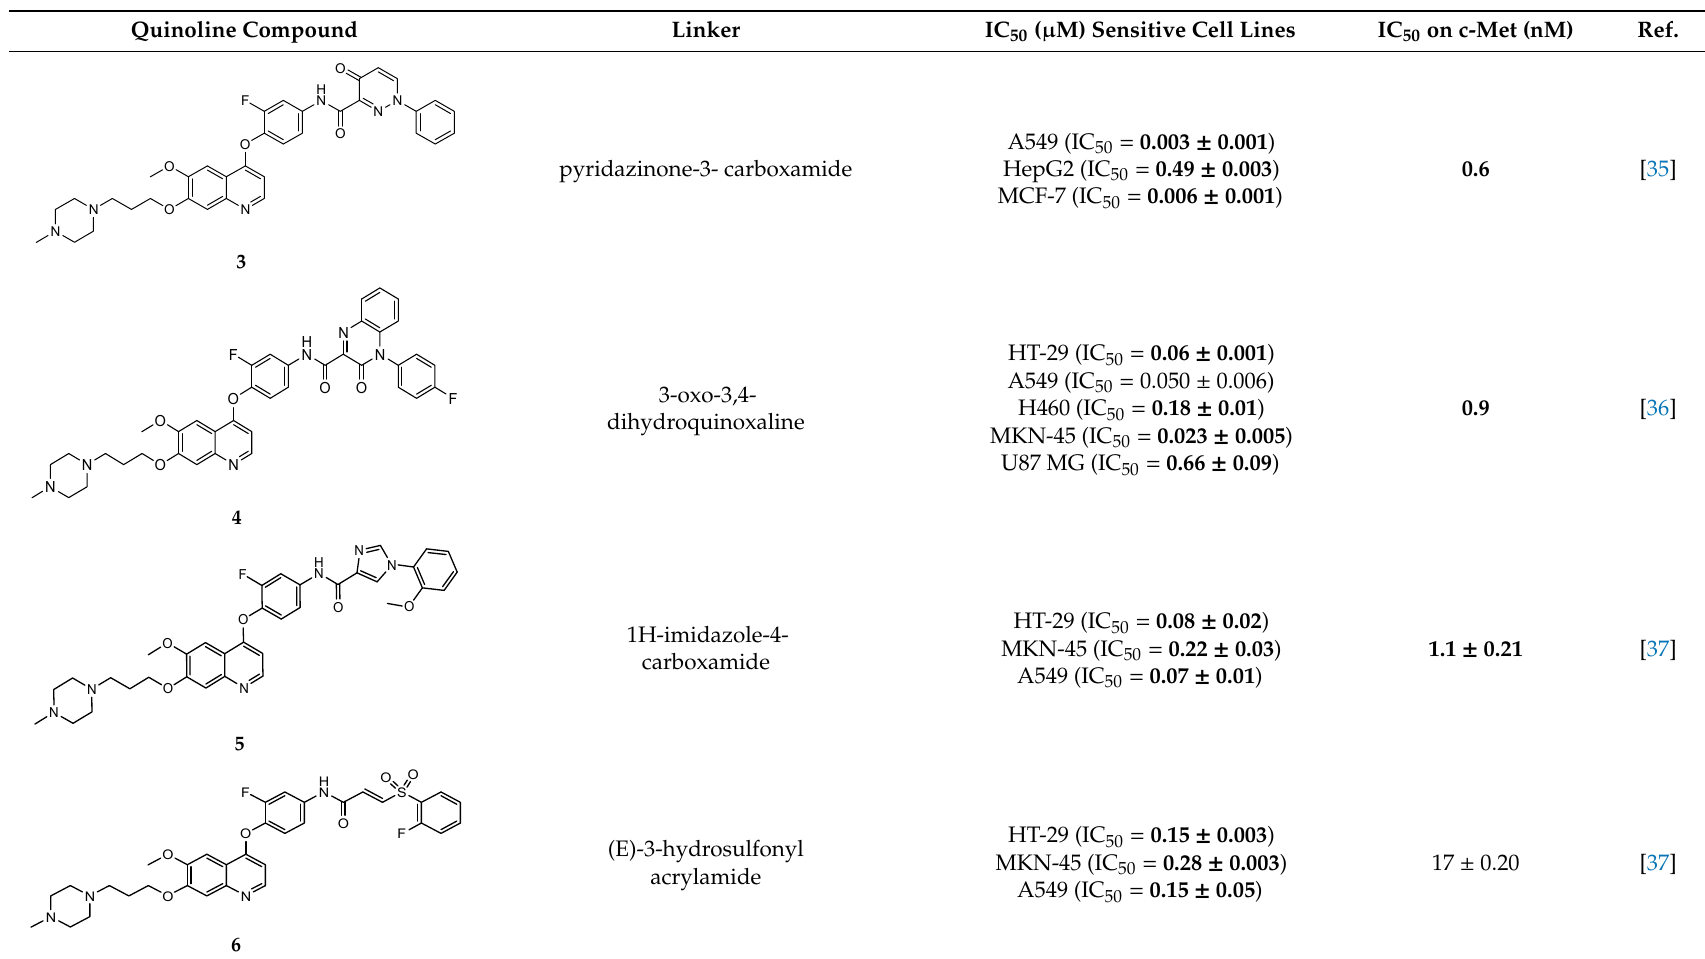
Table 1. Examples of some interesting quinoline based c-Met inhibitors and their corresponding biological activities.